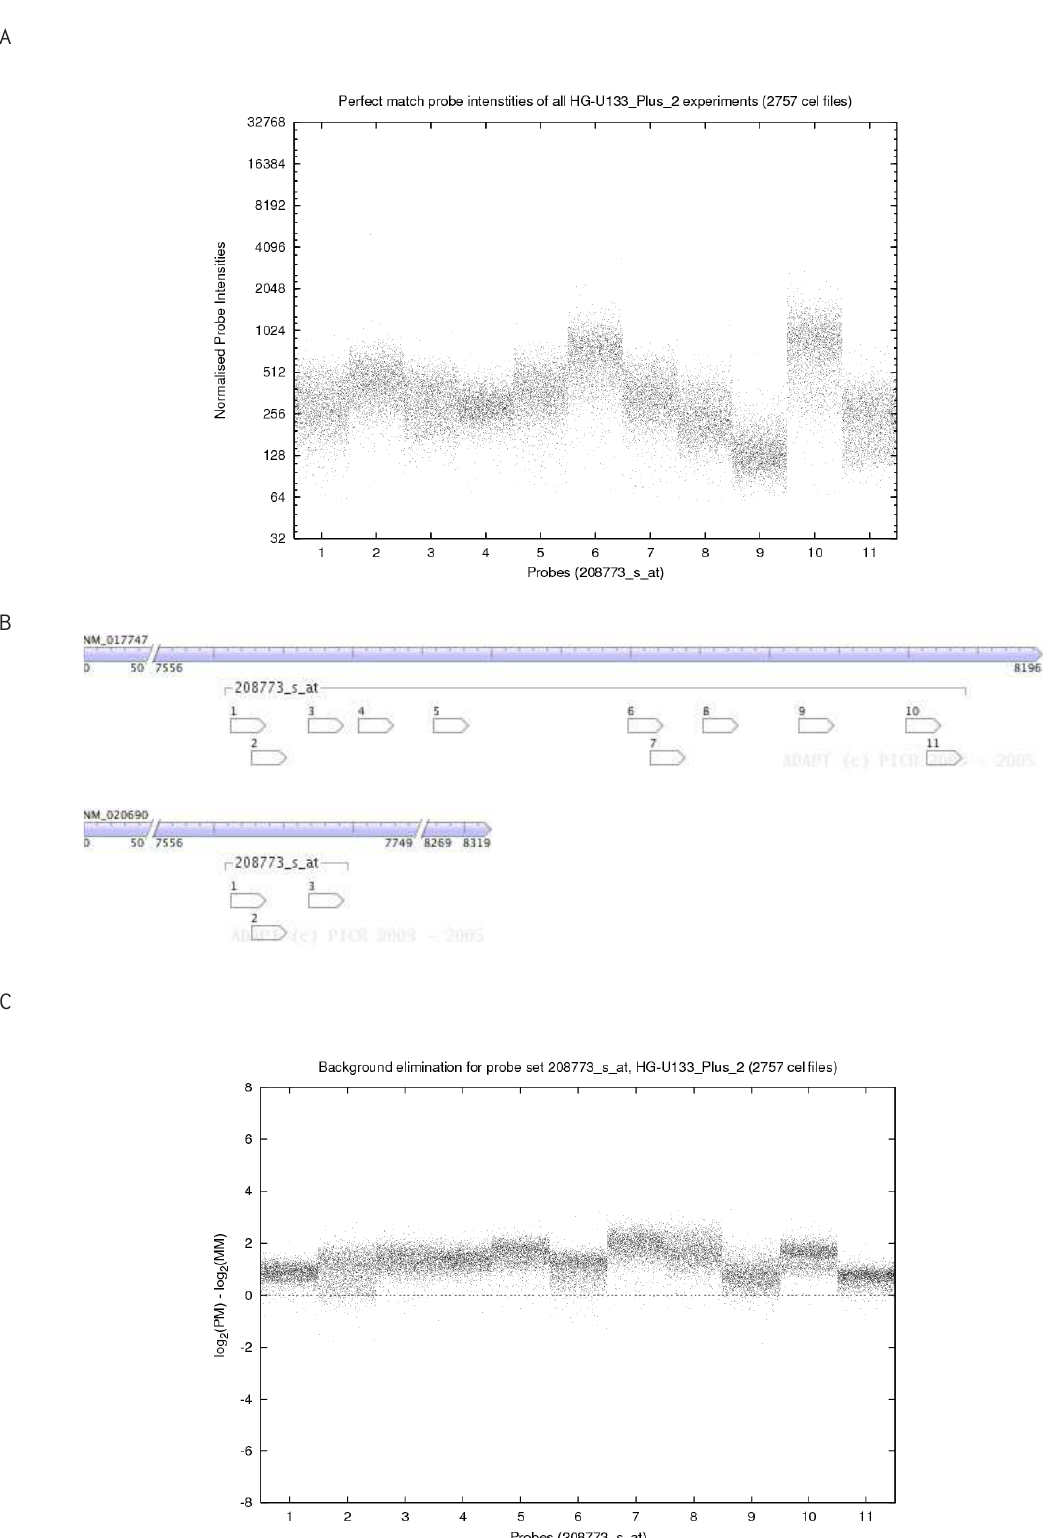
Supplementary Figure 9: Probe intensities over all cel files for probe set 208773 s at on the HG U133 Plus 2 array (A) Perfect match intensities (log scale) (B) ADAPT probe positions on the transcripts (C) Background elimination (log 2 (PM) - log 2